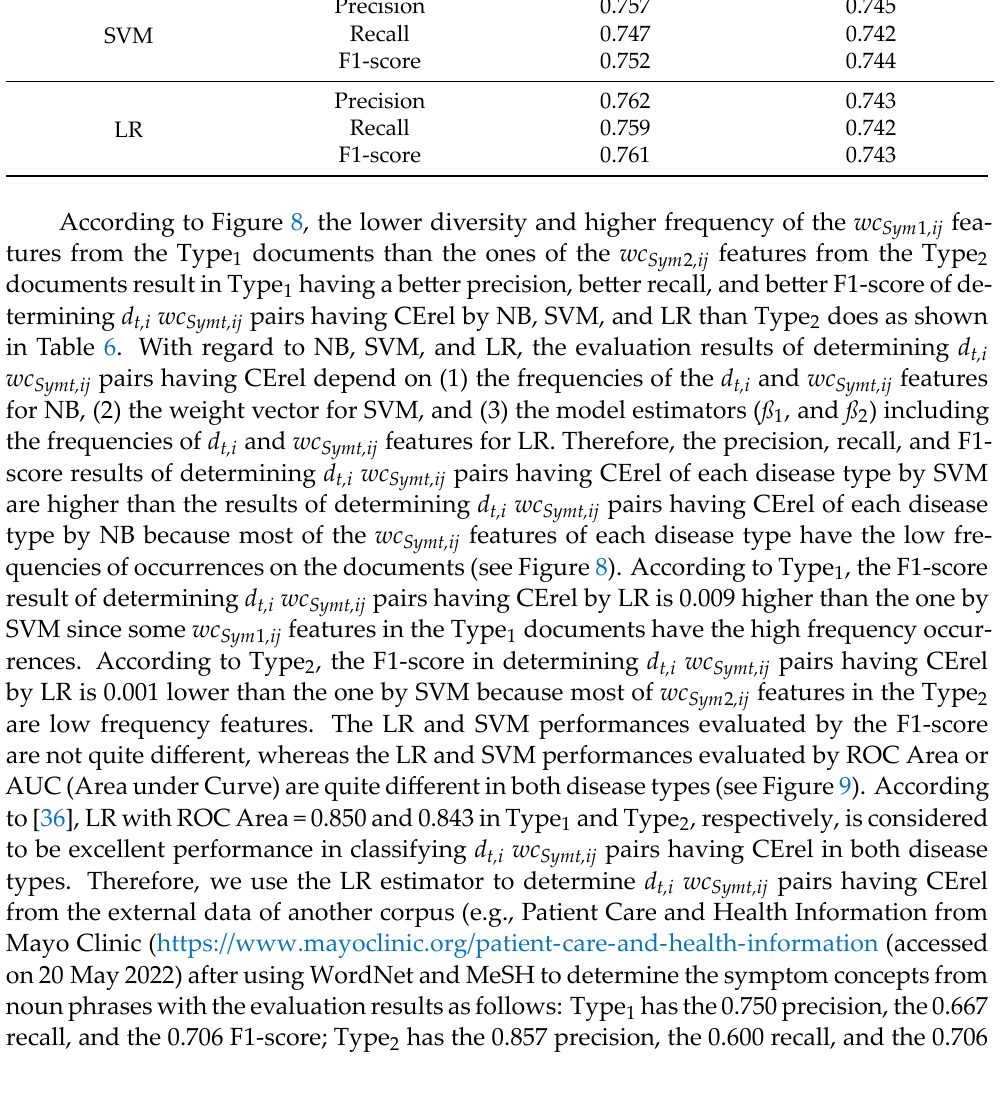
Table 6. Determination of d t,i wc Symt,ij Pairs Having CErel from the second test sample. Determination of d t,i wc Symij Pairs Having CErel